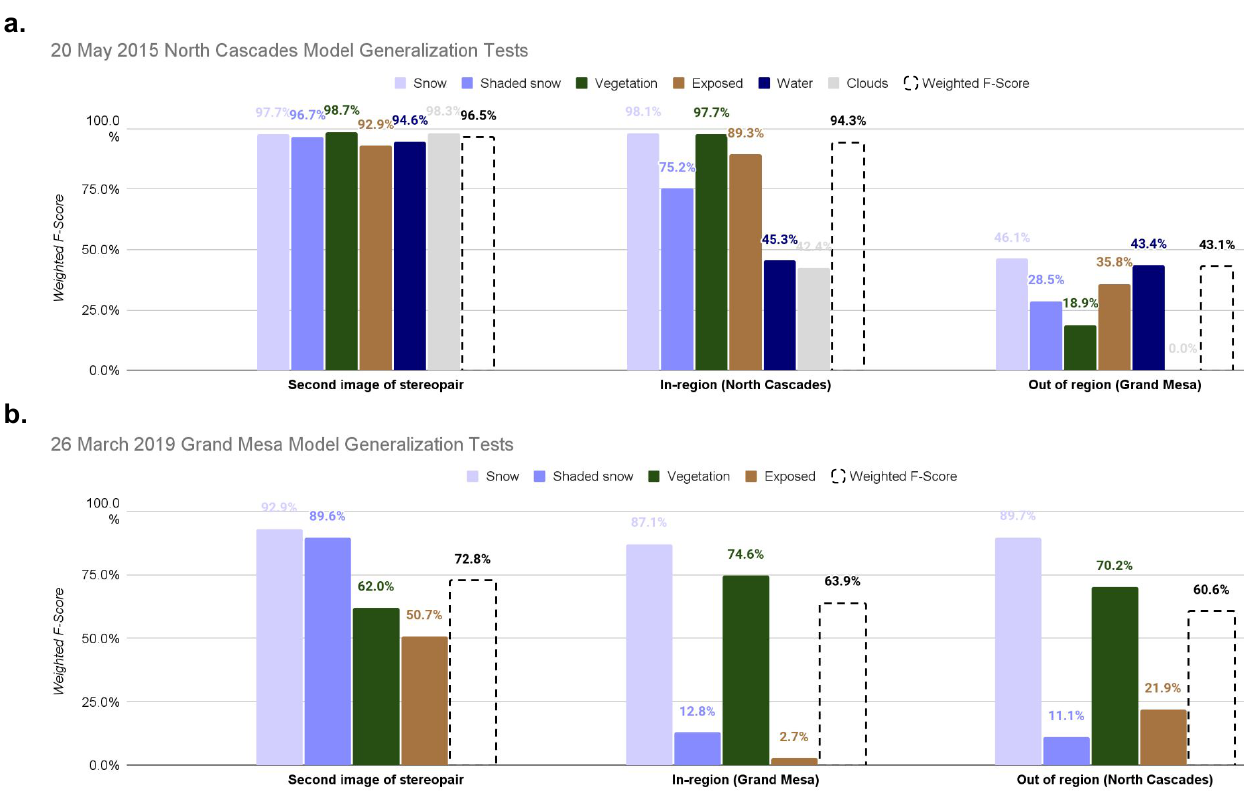
Figure 6. Aggregated results of the model transfer experiments presented in Supplementary Table S3 (the second image of an in-track stereopair, in-region images from the same site as the model, and out-of-region images from a different site than the model) for the ( a ) 20 May 2015 North Cascades base model (M7) and ( b ) 26 March 2019 Colorado Grand Mesa base model (M17). Weighted macro average F-scores are shown for individual feature classes. The expected similarity of images to model training data decreases nonlinearly from left to